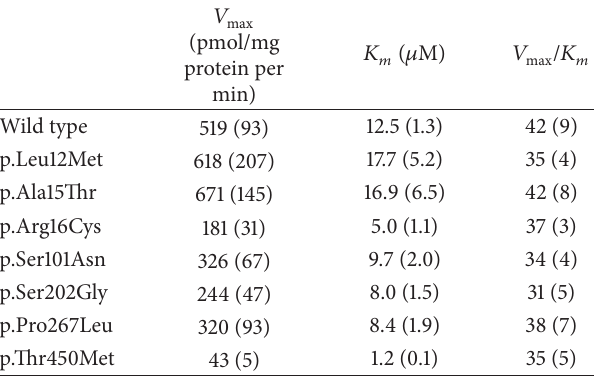
Table 2: Apparent kinetic constants using 17-OHP as